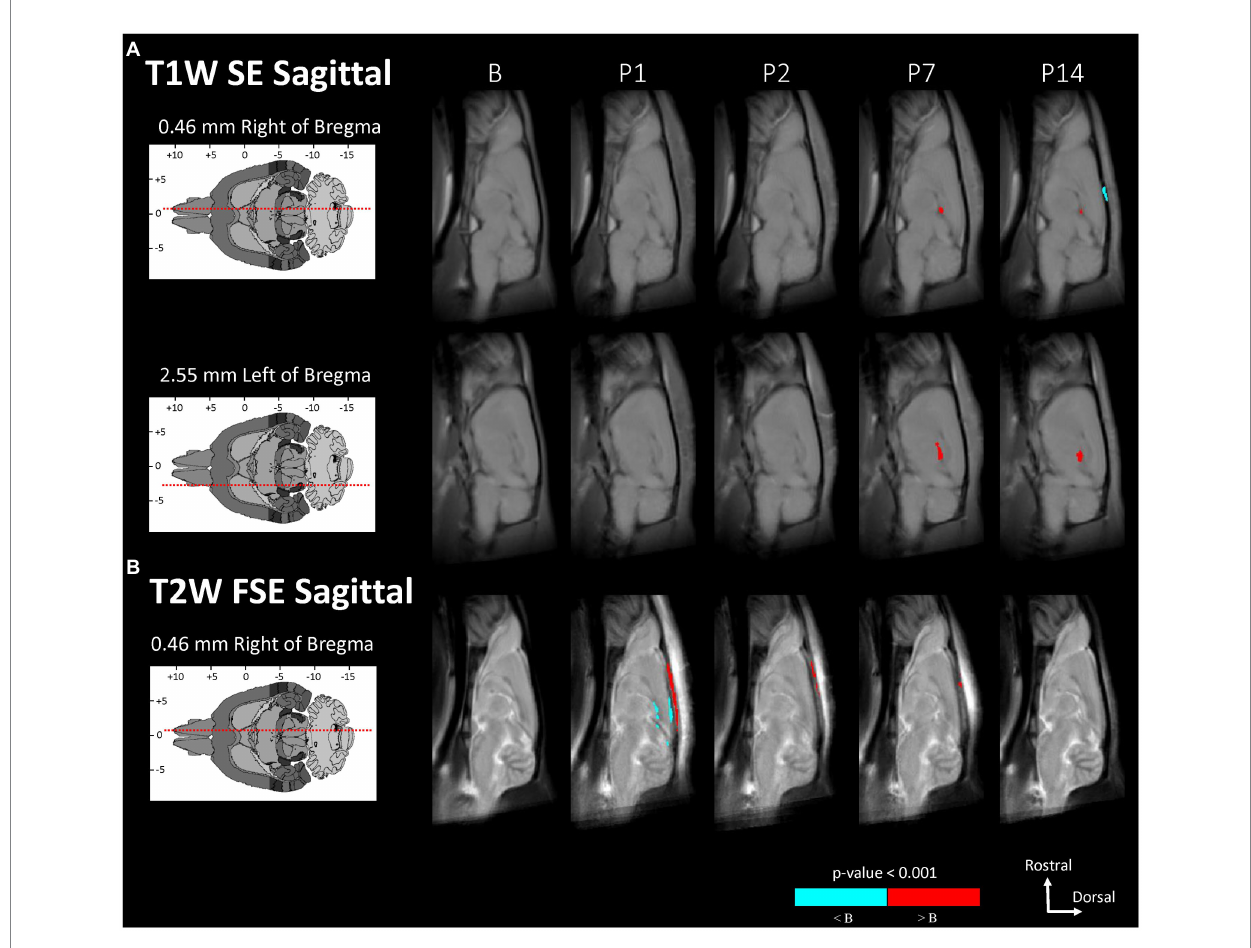
FIGURE 3 Voxel-based morphometry statistical comparisons between baseline and post-injury images grouped by day and sagittal scan, showing only the slices with significantly different voxel clusters for each scan (A,B) . The grayscale brain MRI underlays shown are the average signals of the images grouped by